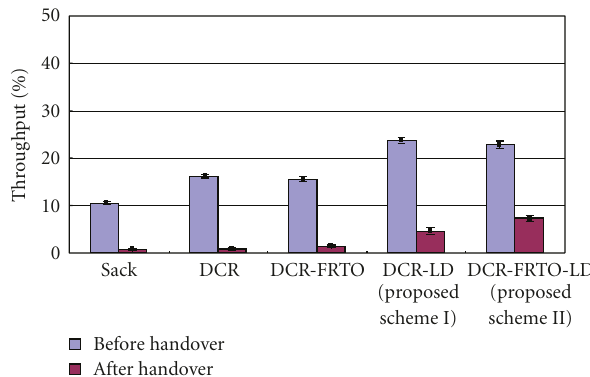
Figure 11: Handover from cellular network to WLAN.